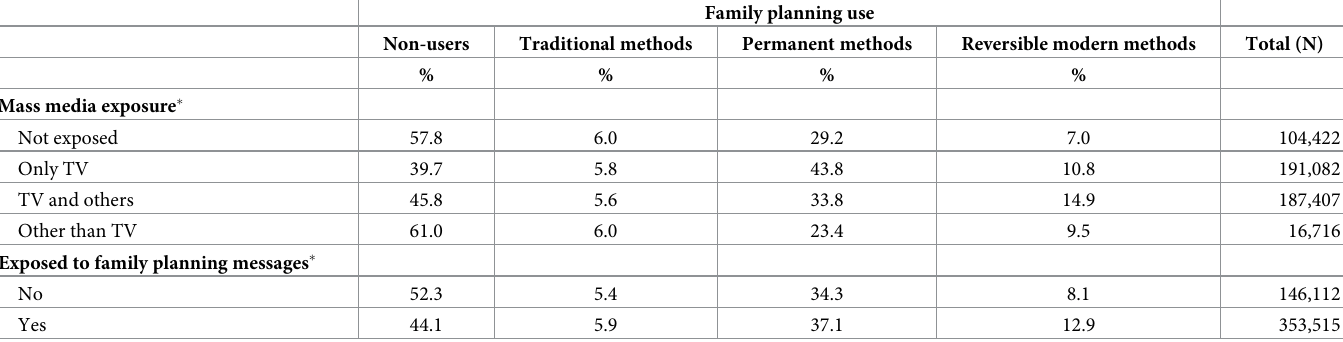
Table 3. Current use of family planning methods by exposure to mass media and exposure to family planning messages among married women aged 15–49 years in India, NFHS